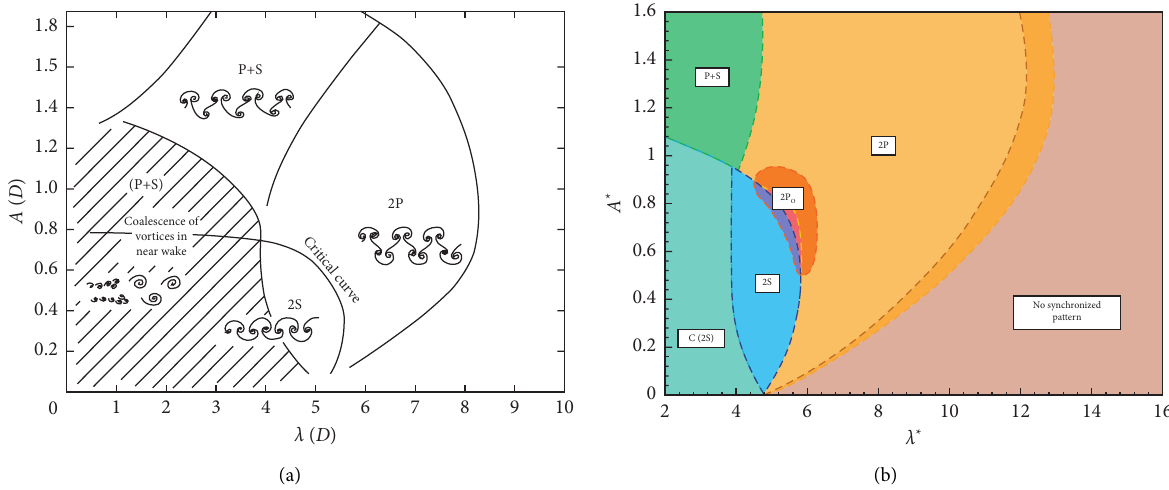
Figure 3: (a) Boundaries of wake modes identified by Williamson and Roshko [18]. (b) Boundaries of wake modes identified by Morse and Williamson [27].